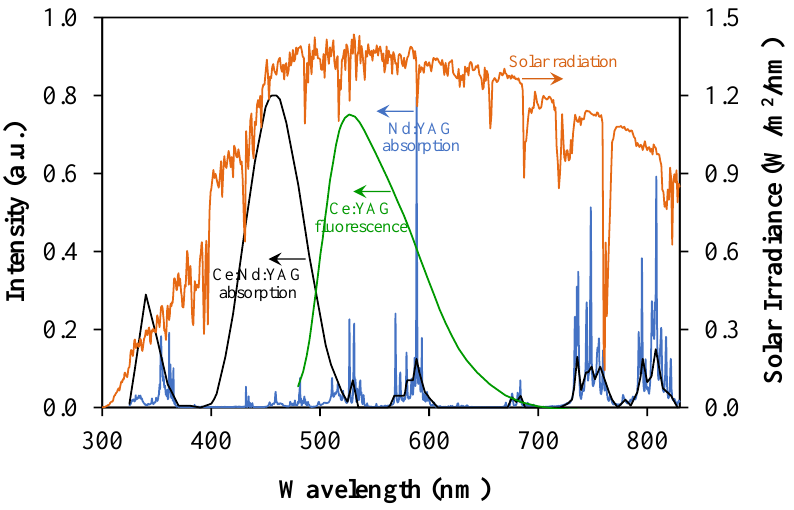
Figure 1. Standard solar emission spectrum (orange line) [33], Ce:YAG fluorescence spectrum (green line) (adapted from [34]), Nd:YAG (blue line) (adapted from [35]), and Ce:Nd:YAG (black line) (adapted from [36]) absorption spectra.